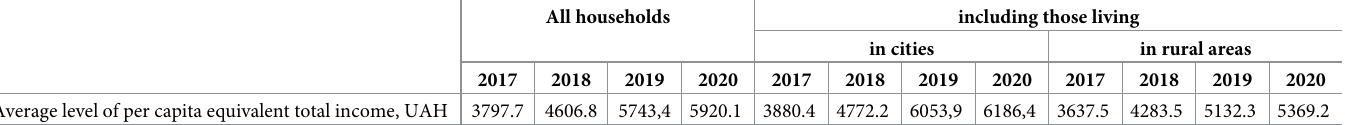
Table 8. Distribution of households by per capita equivalent total income (on average per month). All households including those living in cities in rural